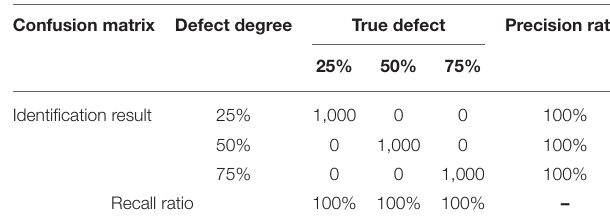
TABLE 6 | Confusion matrix of the identification